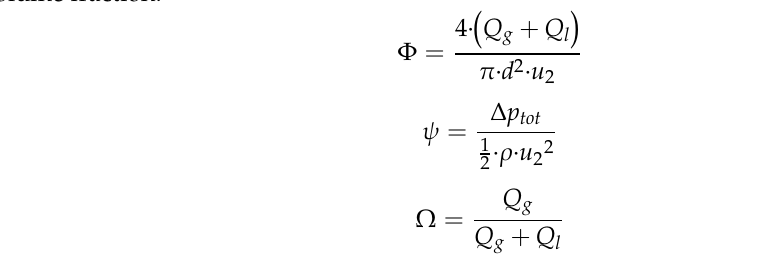
10 of 28 3.2. Experimental Validation with the MUSIG The dimensionless coefficient flow rate (cid:657) and head coefficient (cid:924) were evaluated using Equations